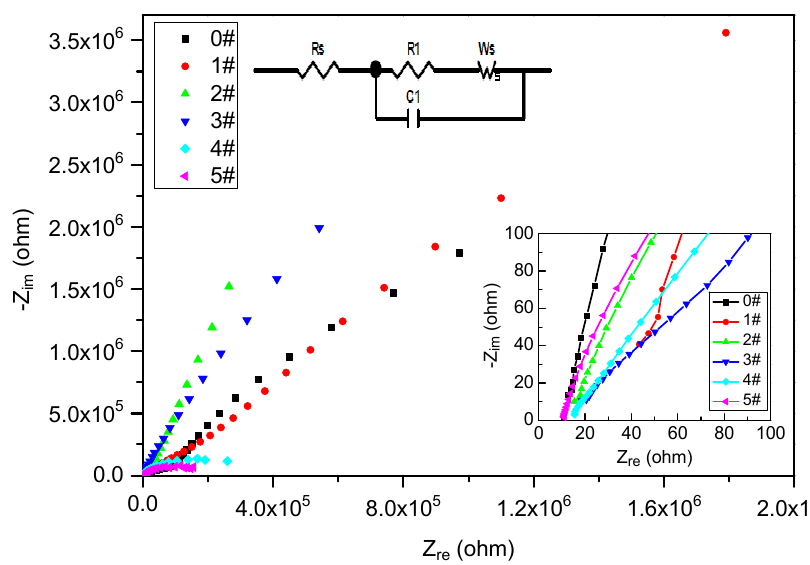
Figure 5. Electrochemical impedance Nyquist diagram of synthesized Ti–O films.